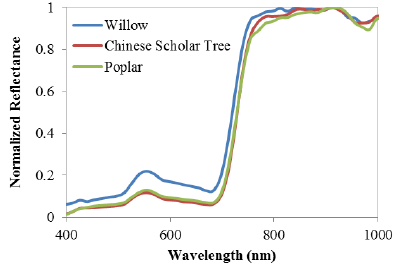
Figure 6. Normalized reflectance spectra of the three tree